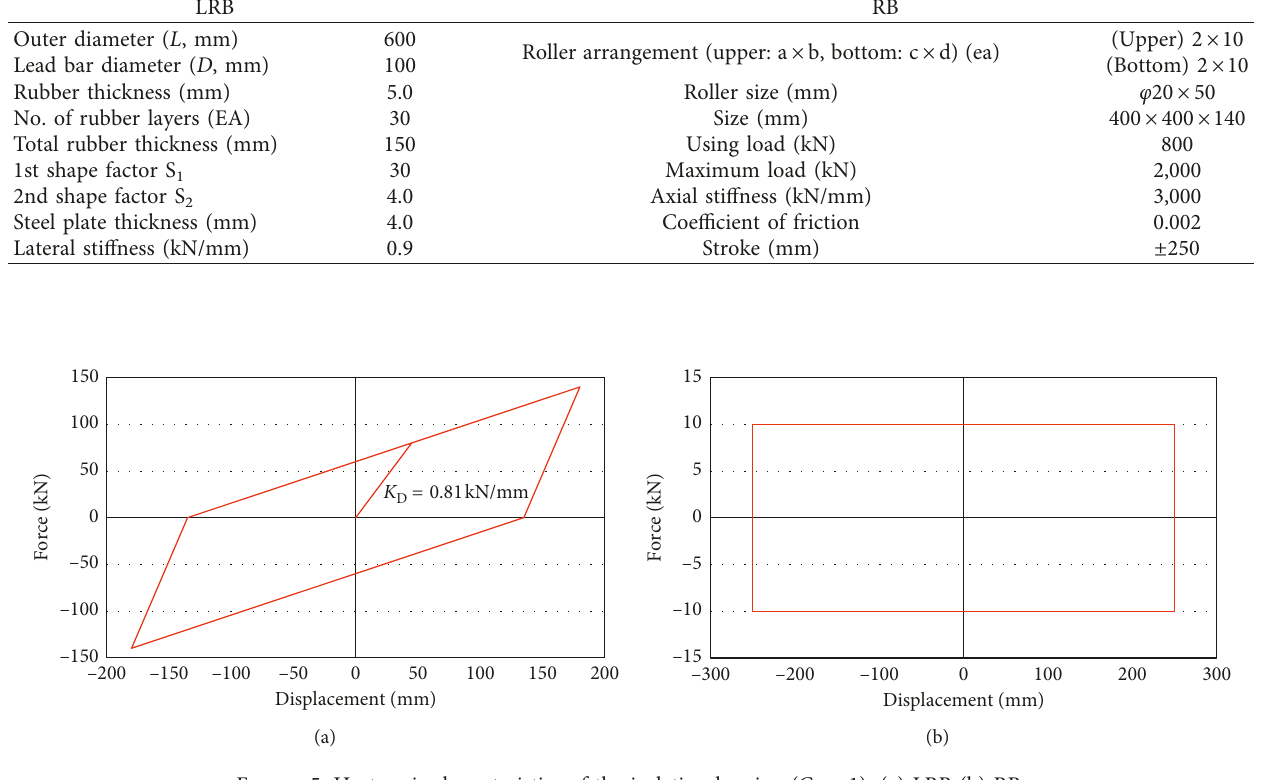
Figure 5: Hysteresis characteristics of the isolation bearing (Case 1). (a) LRB (b) RB.